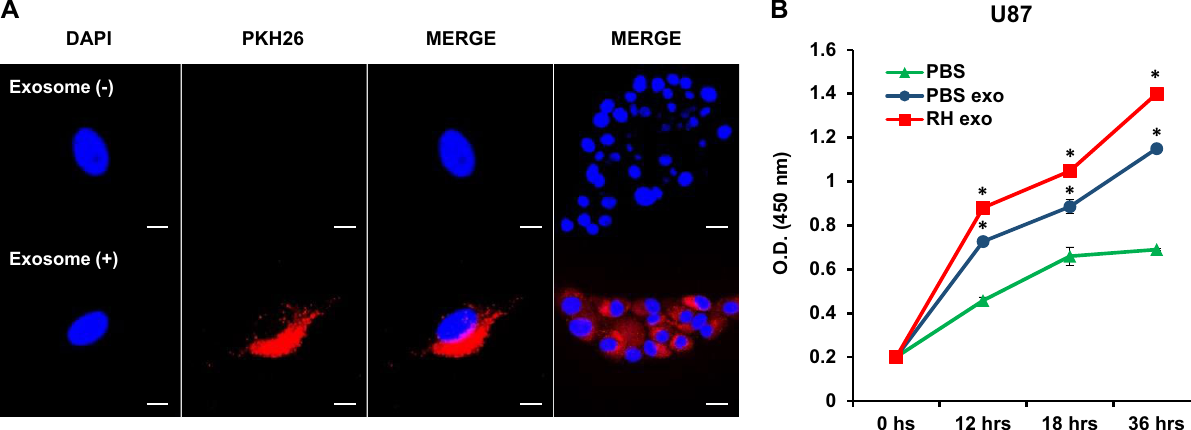
Figure 2. Cellular internalization of BV2-derived exosomes into U87 glioma cells and the proliferation of U87 glioma cells induced by Toxoplasma RH-infected BV2-erived exosomes. ( A ) Exosomes taken up by U87 cells as determined by confocal microscopy. U87 glioma cells were incubated with either PKH26-labeled exosomes (red) or without as control for 24 h. The nuclei of cells were stained with DAPI (blue) before observing in confocal microscopy (scale bars: 10 μm, × 3000). ( B ) The proliferation of U87 glioma cells was determined by a cell proliferation assay. U87 glioma cells were treated with exosomes for the indicated times. * P < 0.05 was obtained by Student’s t